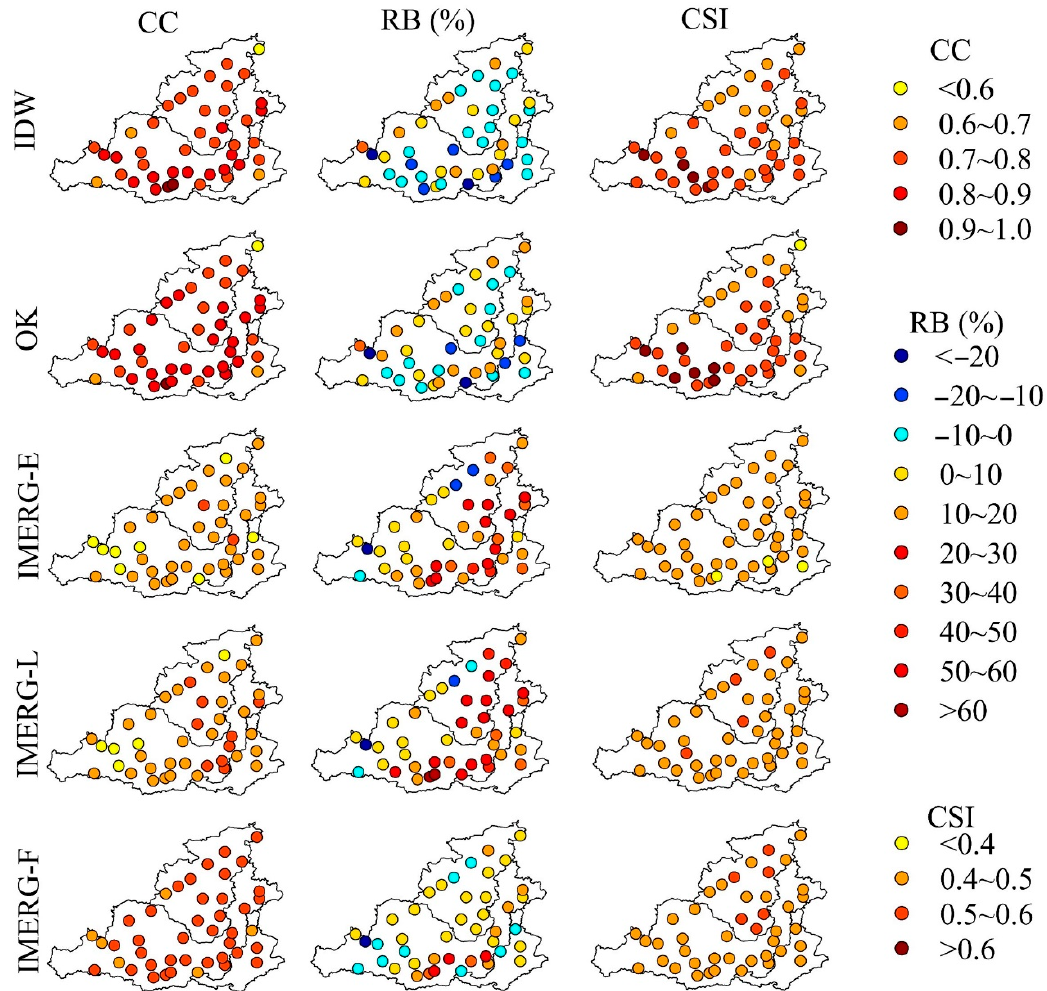
Figure 6. Spatial distribution of CC ( left ), RB ( middle ), and CSI ( right ) of the daily precipitation estimated from two interpolation methods and three IMERG SPPs in MRYRB from 1 January 2008 to 31 December 2019.